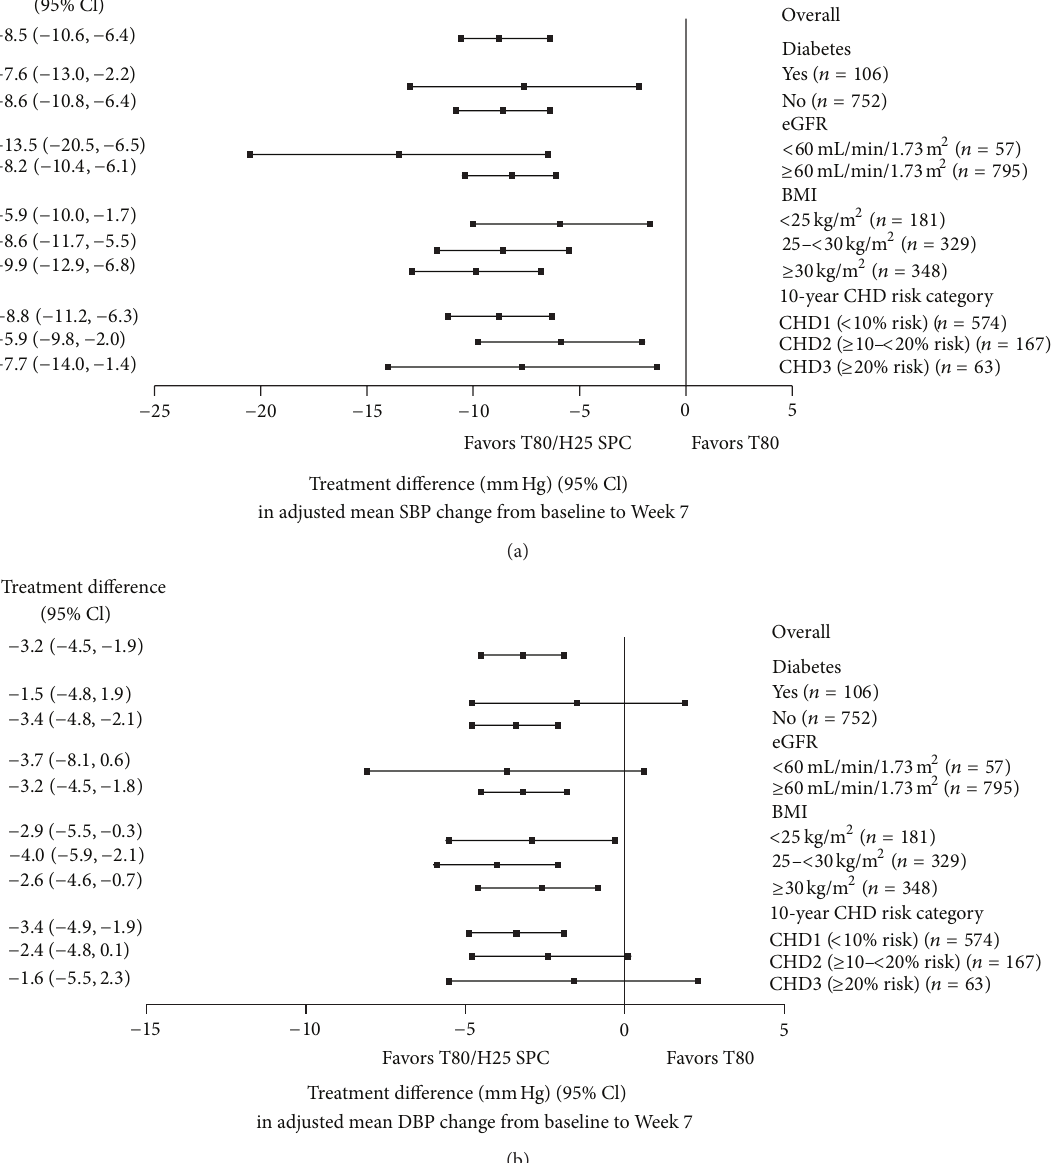
Figure 1: Treatment difference (95% CI) of SPC T80/H25 versus T80 for changes in mean seated trough cuff (a) SBP and (b) DBP from baseline to Week 7 by patient subgroup (FAS). BMI: body mass index; CHD: coronary heart disease; CI: confidence interval; DBP: diastolic bloodpressure;eGFR:estimatedglomerularfiltrationrate;FAS:fullanalysisset;H25:hydrochlorothiazide25 mg;SBP:systolicbloodpressure; SPC: single-pill combination; T80: telmisartan 80